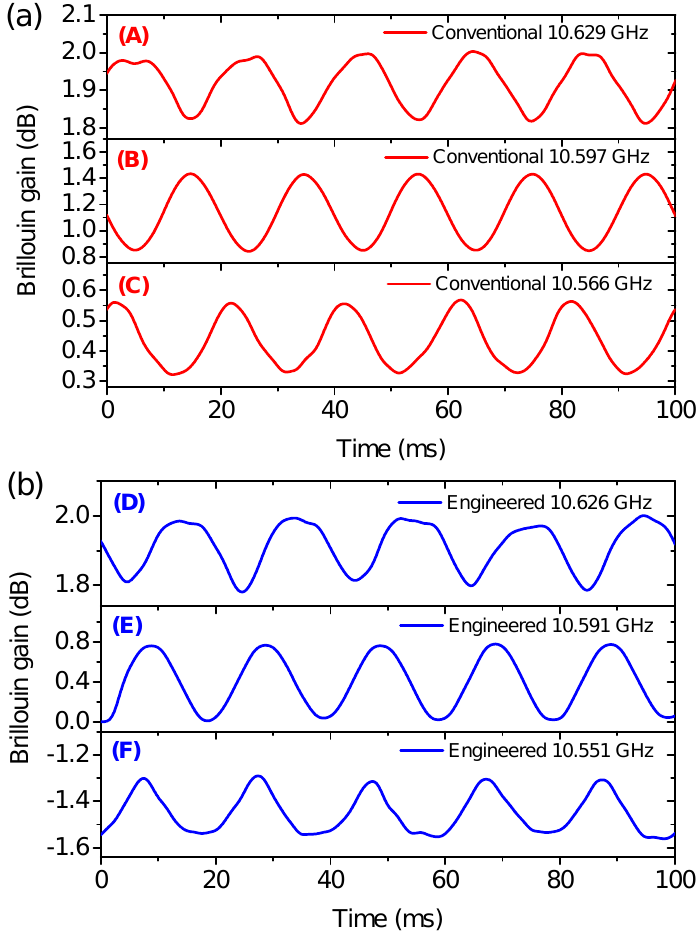
Figure 10. Sinusoidal Brillouin gain response of the conventional ( a ) and engineered ( b ) BGS at the interrogation frequencies in